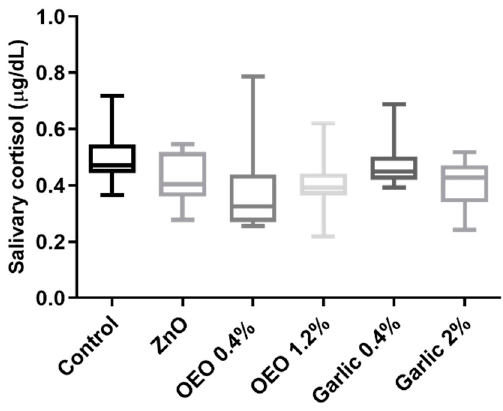
Figure 3. Results for salivary cortisol in piglets supplemented with ZnO, micro capsuled OEO at a concentration of 0.4% in the basal diet, micro capsuled OEO at a concentration of 1.2% in the basal diet, garlic powder at a concentration of 0.4% in the basal diet, and garlic powder at a concentration of 2% in the basal diet. The plots show median (line within box), 25th and 75th percentiles (box), and minimum and maximum values (whiskers).